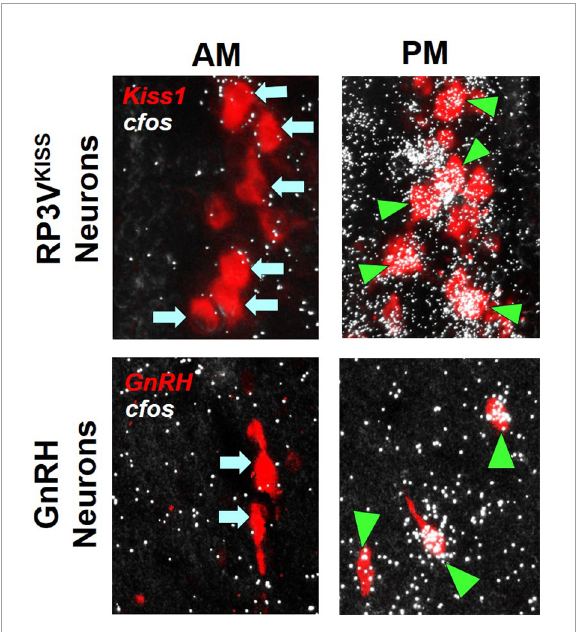
FIGURE1 Examples of RP3V KISS and GnRH neuron activation, as indicated by robust cfos mRNA co-expression (white “silver grains”; assayed with radiolabeled in situ hybridization), during an E 2 -induced LH surge in female mice. The surge typically occurs in the late afternoon/early evening (PM) but not in the morning (AM), matching the higher degree of cfos mRNA induction in both RP3V KISS and GnRH neurons in the PM than AM. Green triangles denote example “activated” RP3V KISS or GnRH cells co-expressing cfos; blue arrows denote example non-activated cells lacking cfos . Adapted from Poling et al.